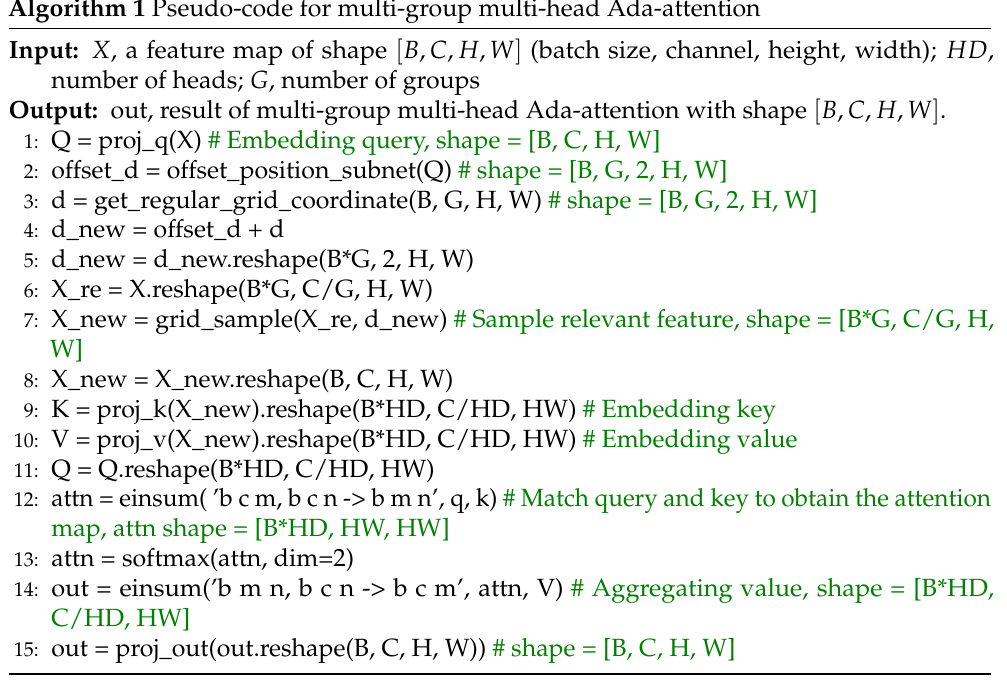
Algorithm 1 Pseudo-code for multi-group multi-head Ada-attention